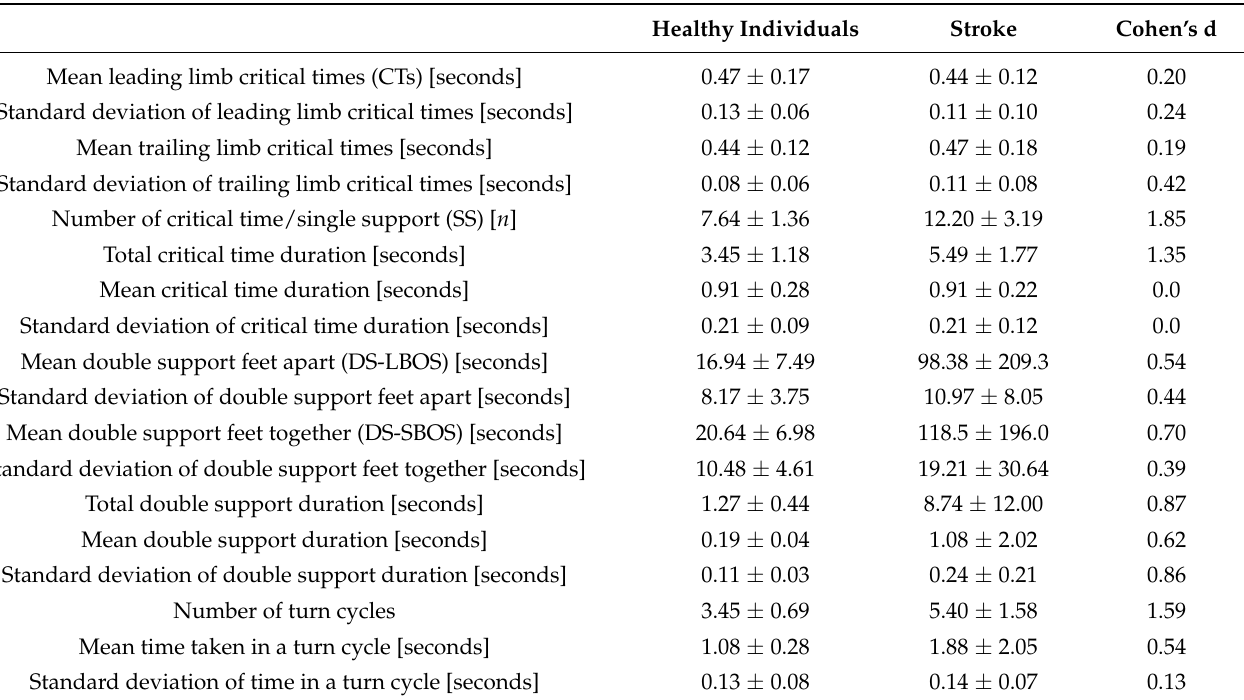
Table 2. Comparisons of kinematic turning variables (means ± SD) between stroke and older